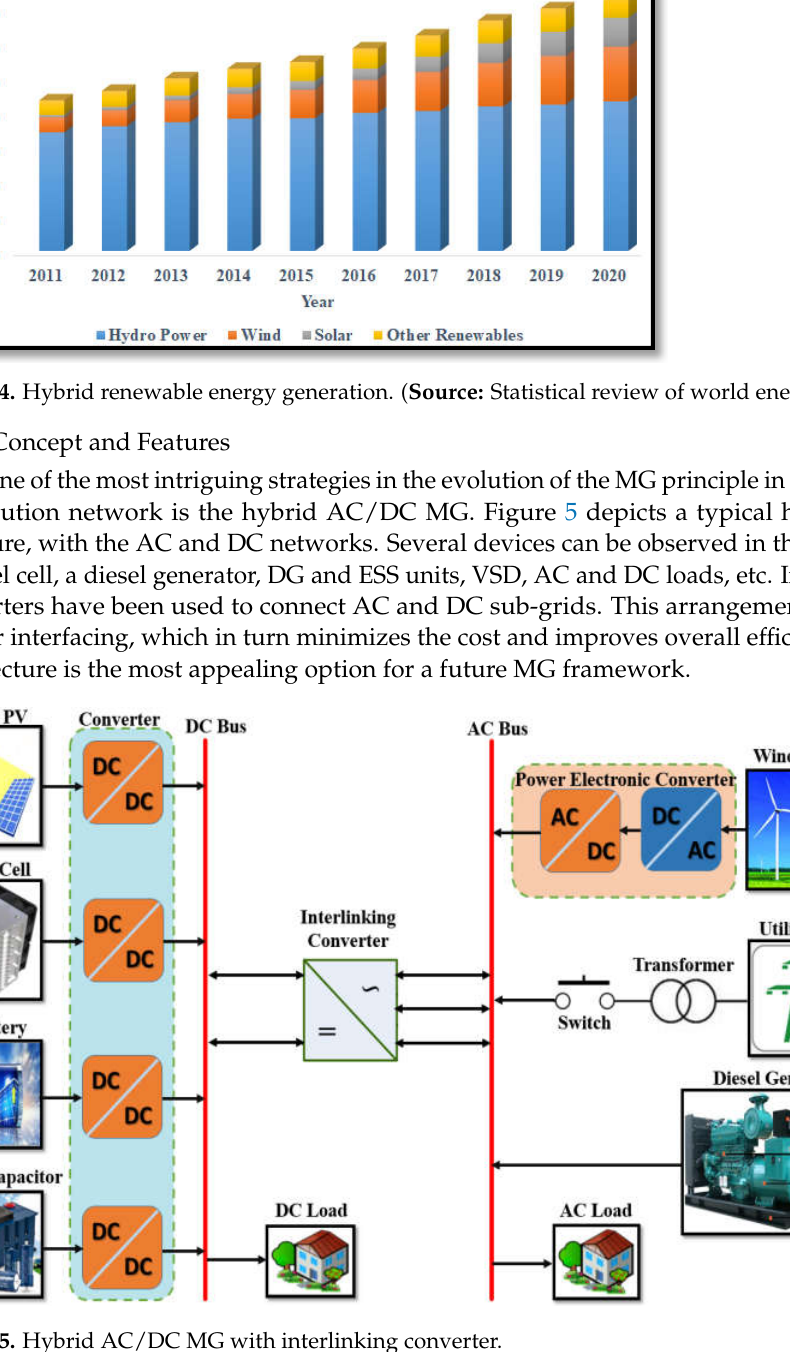
Figure 5. Hybrid AC/DC MG with interlinking